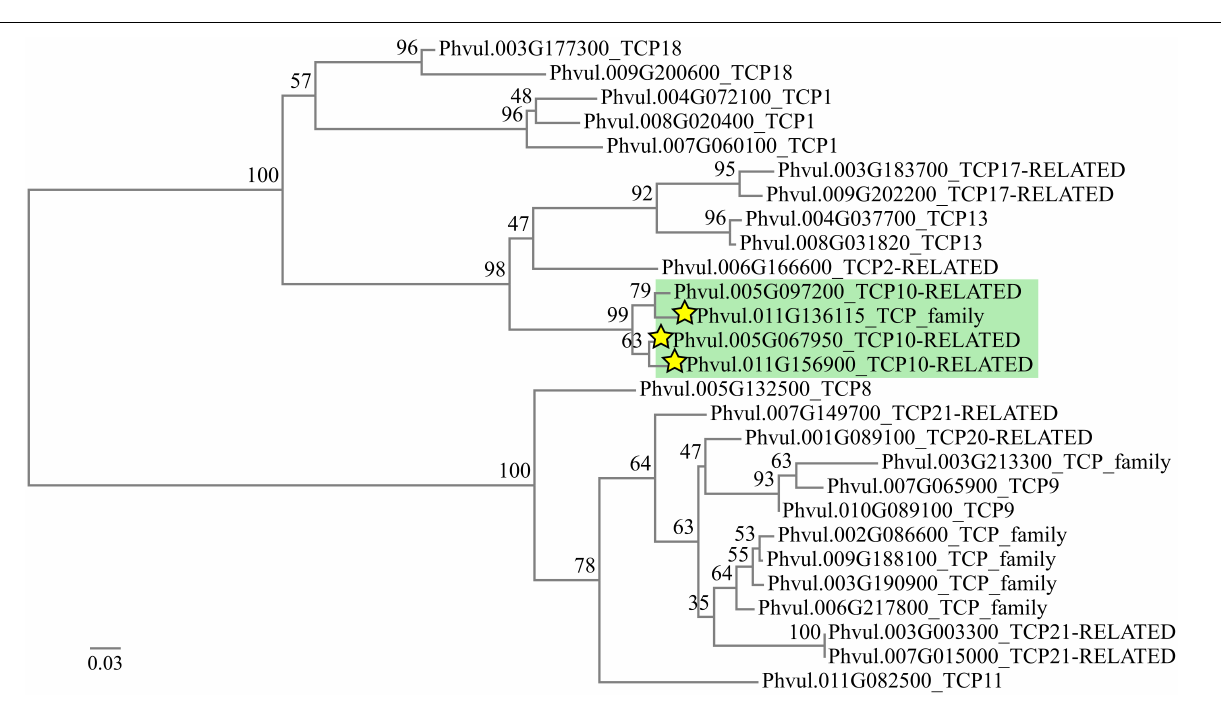
FIGURE 2 | Phylogenetic tree of 27 TCP sequences from Phaseolus vulgaris . Numbers at the branch dichotomy represent the bootstrap values obtained after 100 resampling. The green box contains the transcripts predicted as miR319 targets. Stars indicate the transcripts found as degraded by a member of the miR319 family in the degradome data from Formey et al. (2015). Scale bar represents the branch